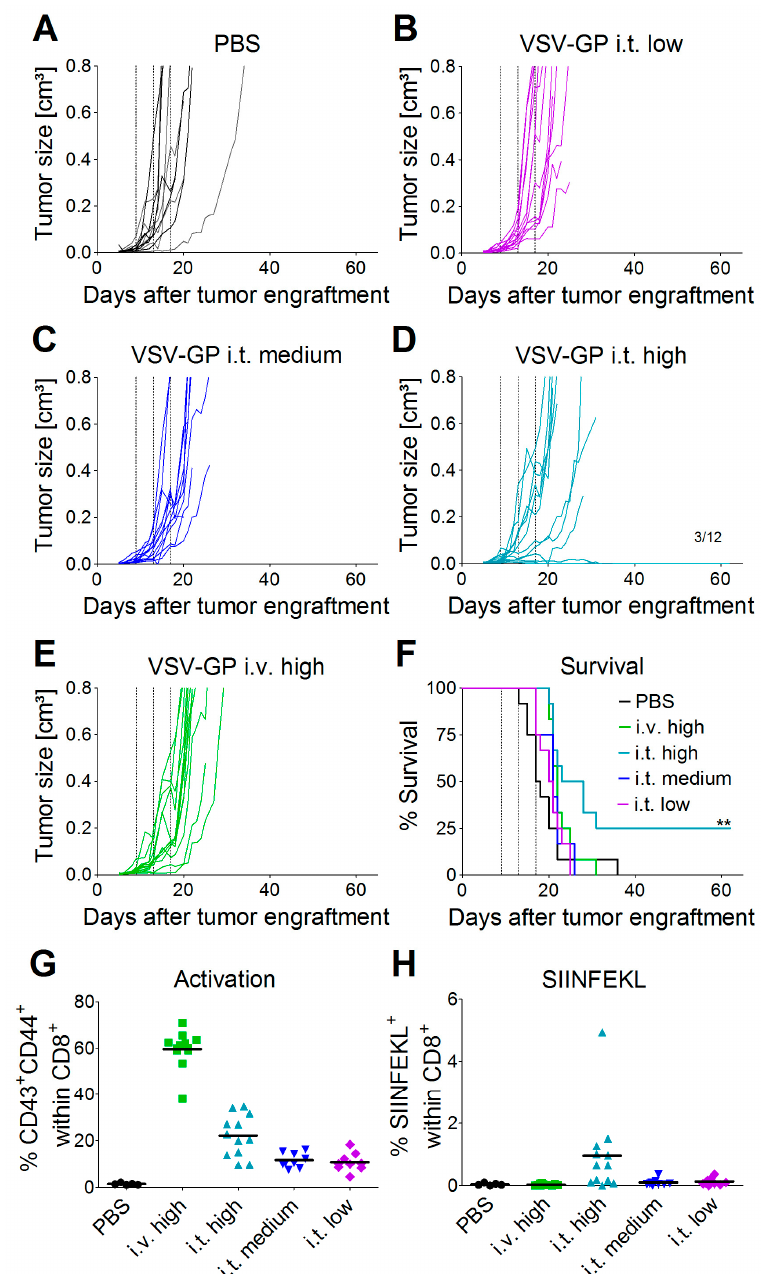
Figure 3. Efficacy of intratumoral treatment with VSV-GP in a syngeneic melanoma mouse model. 5 × 10 5 B16-OVA cells were injected subcutaneously into C57BL/6 mice. On days 9, 13, and 17 post-transplantation, mice were treated with either PBS (six mice intratumorally = black lines, and six mice intravenously = grey lines, ( A )), a low intratumoral (2.36 × 10 4 PFU, ( B )), a medium intratumoral (4.72 × 10 5 PFU, ( C )), a high intratumoral (2.36 × 10 7 PFU, ( D )) or a high intravenous (2.36 × 10 7 PFU, ( E )) dose of VSV-GP-GFP, n = 12. Animals were monitored for tumor growth, and sacrificed when tumor volume reached 0.8 cm 3 or tumors ulcerated. ( F ) Kaplan–Meier survival curve. Dotted lines indicate time points of virus injection. ** p = 0.003, PBS vs. i.t. high, Log-rank (Mantel–Cox) Test. On day 2 after the third virus injection, blood was collected from the tail vein. The activation of CD8 + T-cells ( G ) and the percentage of SIINFEKL-specific cytotoxic T-cells (CTL) ( H ) were analyzed via flow cytometry.